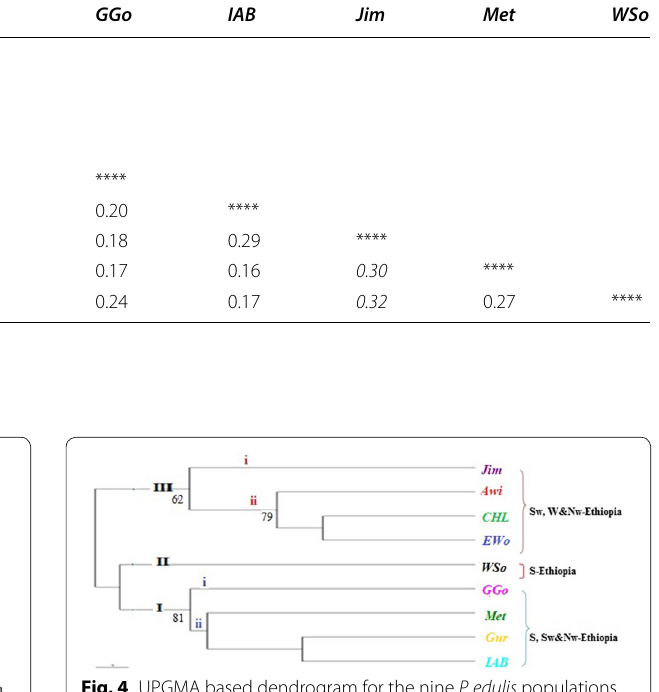
Fig. 4 UPGMA based dendrogram for the nine P. edulis populations used in the study. Numbers at the roots of the branches are bootstrap values, and bootstrap values of less than 60% were not shown